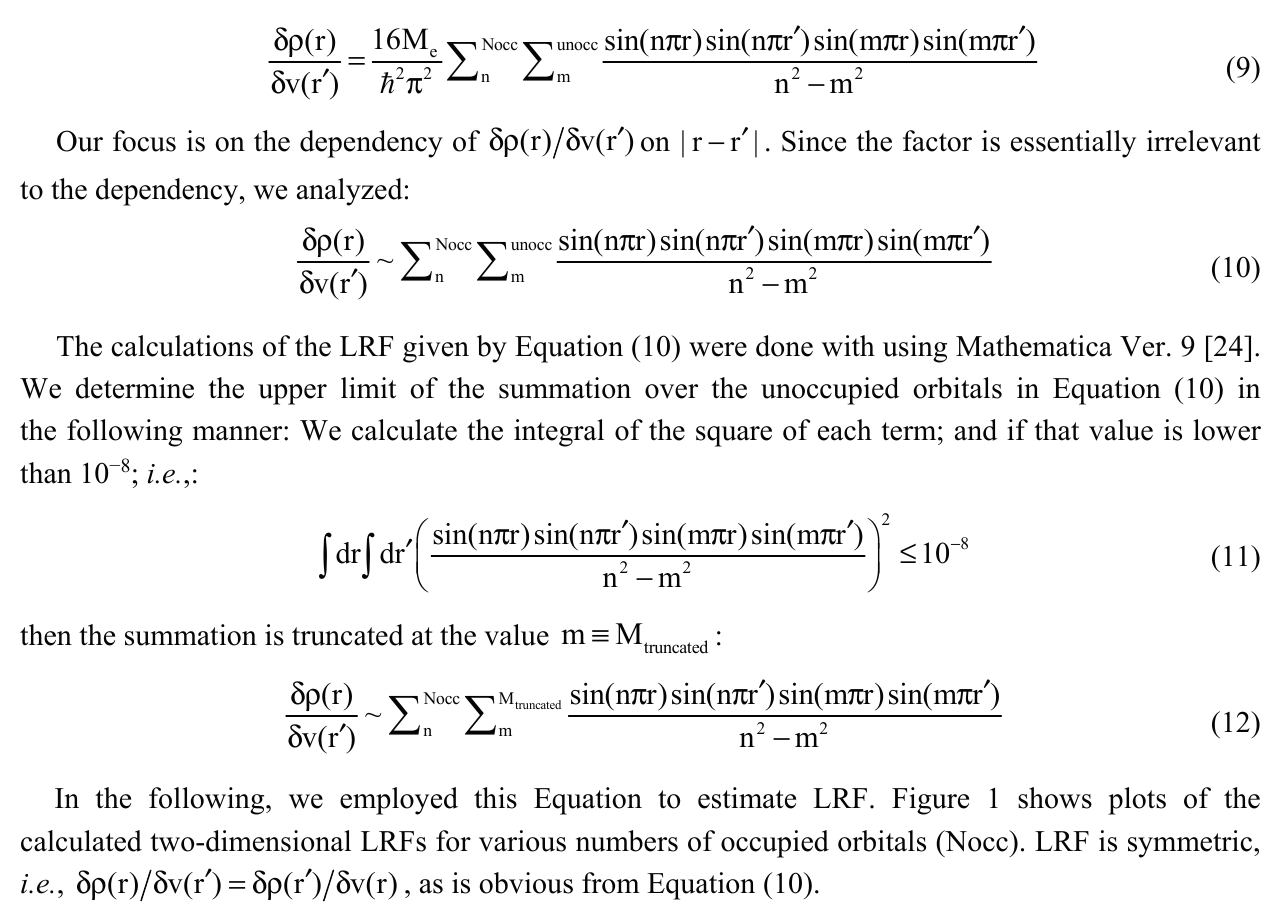
Figure 1. Plots of linear response functions of the infinite square-well potential system for various numbers of occupied orbitals (Nocc). ( a ) Nocc = 1; ( b ) Nocc = 2; ( c ) Nocc =